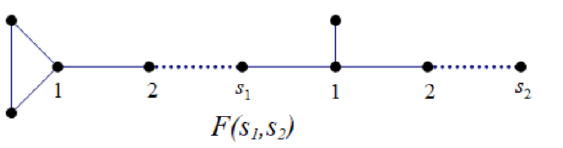
Figure 4. F ( s 1 , s 2 )